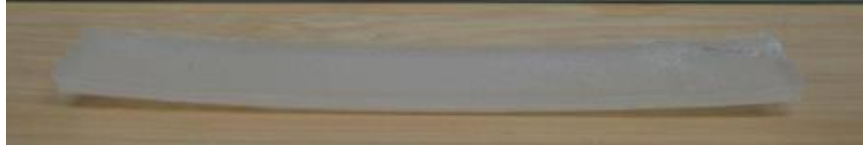
Figure 2. Test sample printed by fresh PA12.